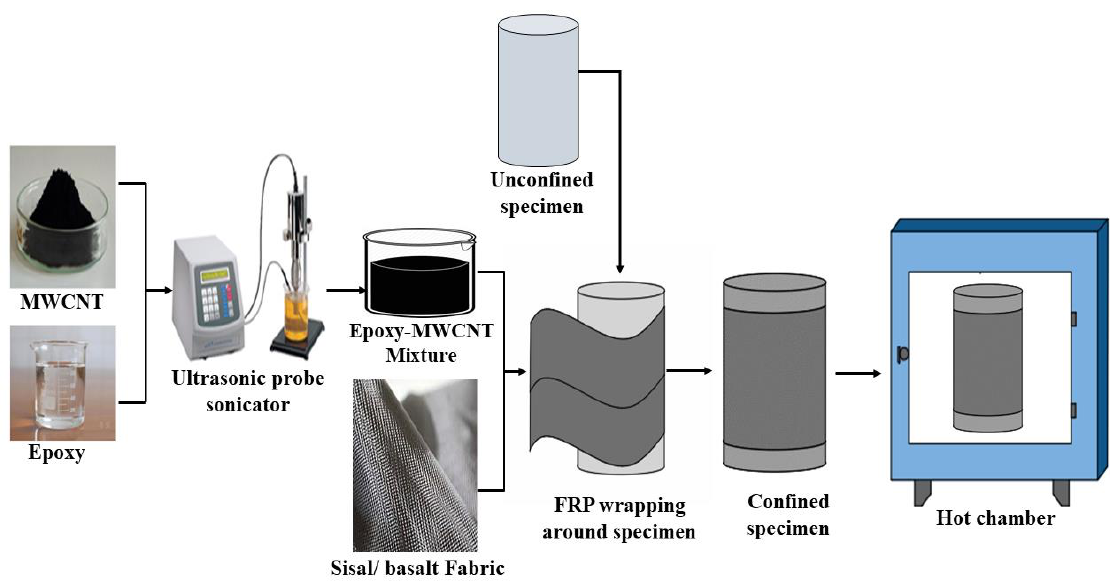
Figure 1. Schematic representation of test program.